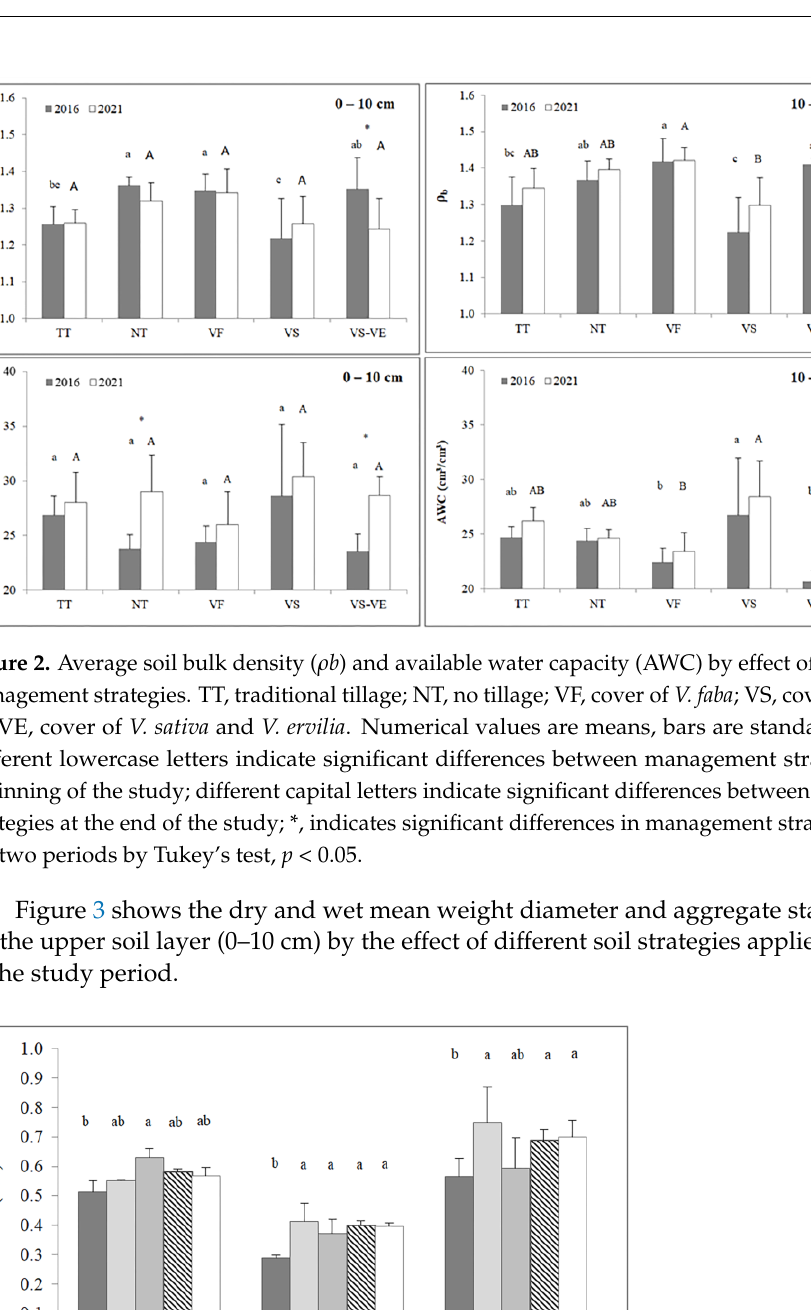
Figure 3. Dry and wet mean weight diameter (MWD) and aggregate stability index (ASI) by effect of different soil management strategies. TT, traditional tillage; NT, no tillage; VF, cover of V. faba ; VS, cover of V. sativa ; VS-VE, cover of V. sativa and V. ervilia . Bars are standard deviation. Different letters indicate significant differences between management strategies (Tukey’s test, p < 0.05).